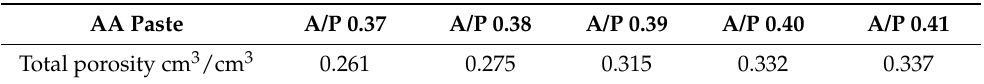
Figure 13. The differential distribution curve for the specimens cured for 28 days. Table 3. Total porosity in Alkali-activated AA paste at 28 days.